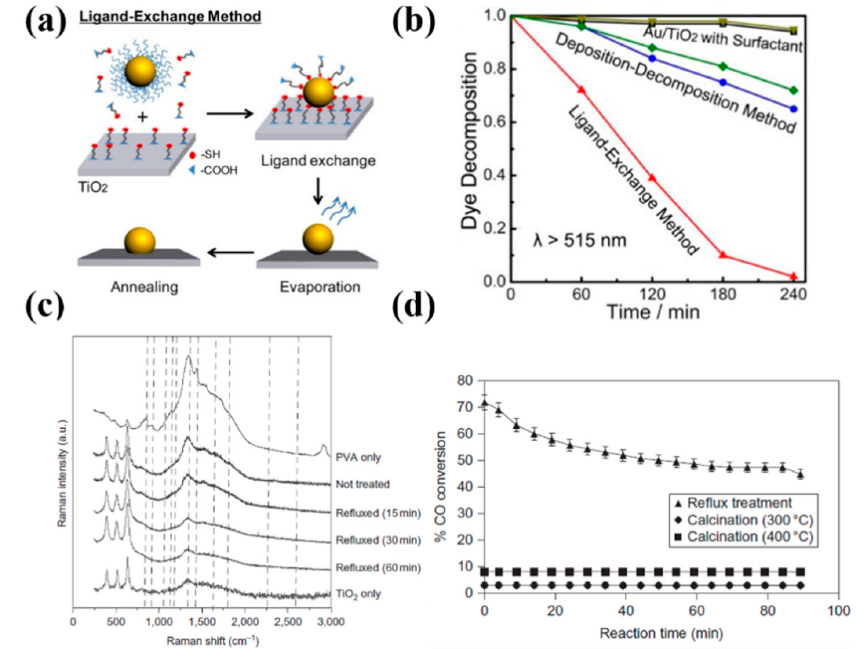
Figure 8. The efficient transfer of HCs by involving a post-treatment. ( a ) The scheme for forming a compact contact between Au and TiO 2 by ligand exchange and annealing, successively. ( b ) The rates of dye decomposition under different methods. ( a , b ) Reproduced with permission. [96] Copyright 2014, American Chemical Society. ( c ) The measured Raman intensity of Au/TiO 2 under different refluxed times. ( d ) The conversing efficiency of CO in Au/TiO 2 treated by reflux treatment and high-temperature calcination (300 °C and 400 °C). ( c , d ) Reproduced with permission. [97] Copyright 2011, Springer Nature.